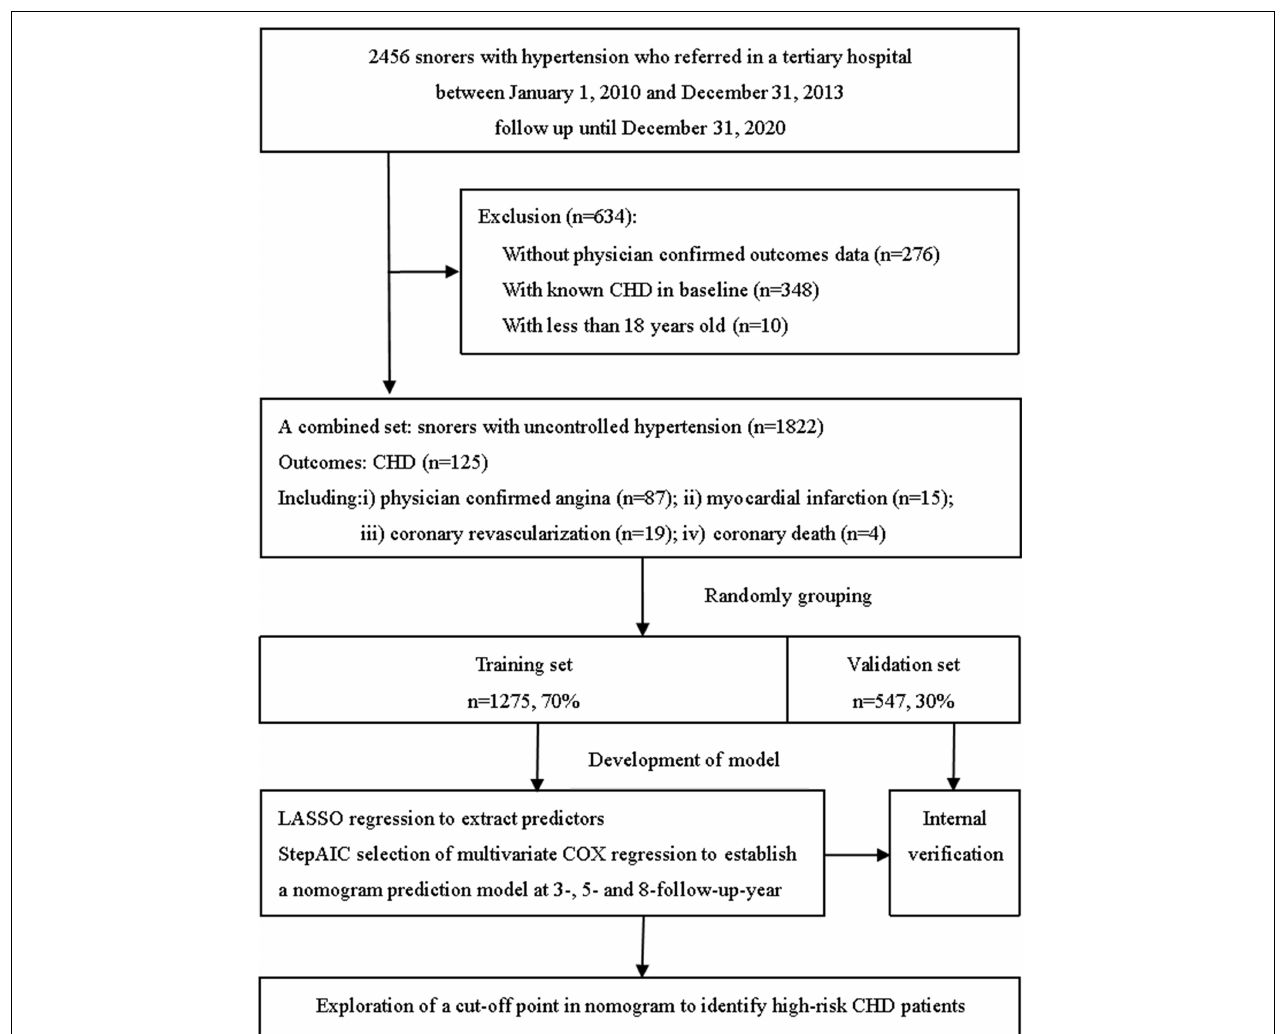
FIGURE 1 | The flowchart of this study